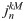
Model system.(A) A piece of neural tissue was subdivided into 15 subvolumes (depth intervals). The edges n = 1 and n = 15 were auxiliary compartments used to implement appropriate boundary conditions. In these subvolumes ion concentrations were set to be constant baseline levels. In n = 1, the ECS potential was set to V = 0, while in n = 15, V was derived so that no net current entered/left the system (see Methods for details). A population of 10 neurons (only one shown in the figure) was positioned so that it occupied the interior 13 subvolumes. The output of specific ions into each subvolume was computed for all segments of all 10 neurons and summed, yielding the total input of an ion species k to each subvolume (illustrated by red arrows). (B) Ion-concentration dynamics in an ECS subvolume n. Here jnkM denotes the total transmembrane flux density of ion species k into the subvolume n from the whole population of neurons. jkf and jkd denote ECS flux densities between neighboring subvolume driven by electrical potential differences and diffusion, respectively. (C) The extracellular potential is calculated by demanding that the sum of currents into each ECS subvolume is zero. Currents were determined by summing the contributions from all ionic fluxes (red arrows), and adding the capacitive current (black arrows).